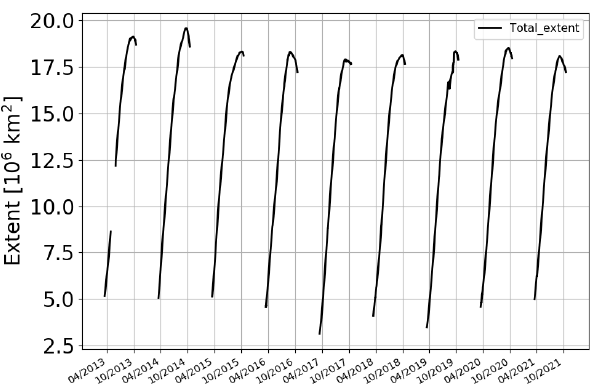
Figure 13. Total sea ice extent of the Antarctic sea ice, years 2013– 2021, calculated from the sum of YI, FYI, and MYI concentrations and smoothed with a 31d moving average.